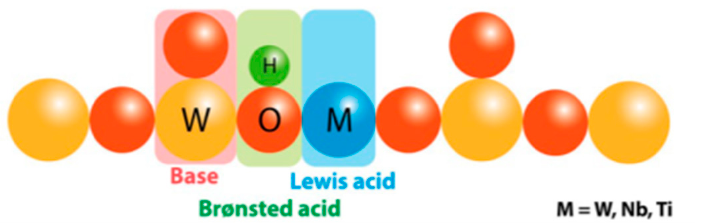
Figure 17. Active centers in MWO3 catalytic systems. Reproduced with permission from ref. [141] Copyright © 2018